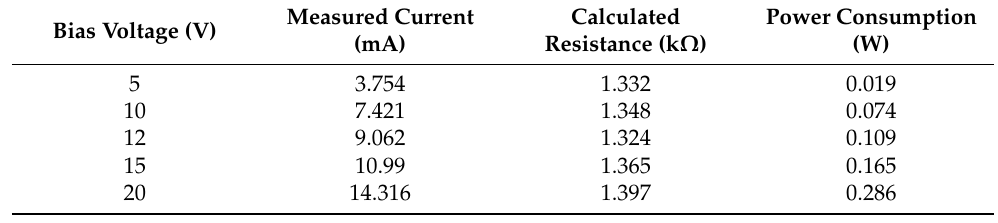
Figure 5. Measured normalized mode crosstalk of ( a ) MDM CH1, ( b ) MDM CH2 and ( c ) MDM CH3.